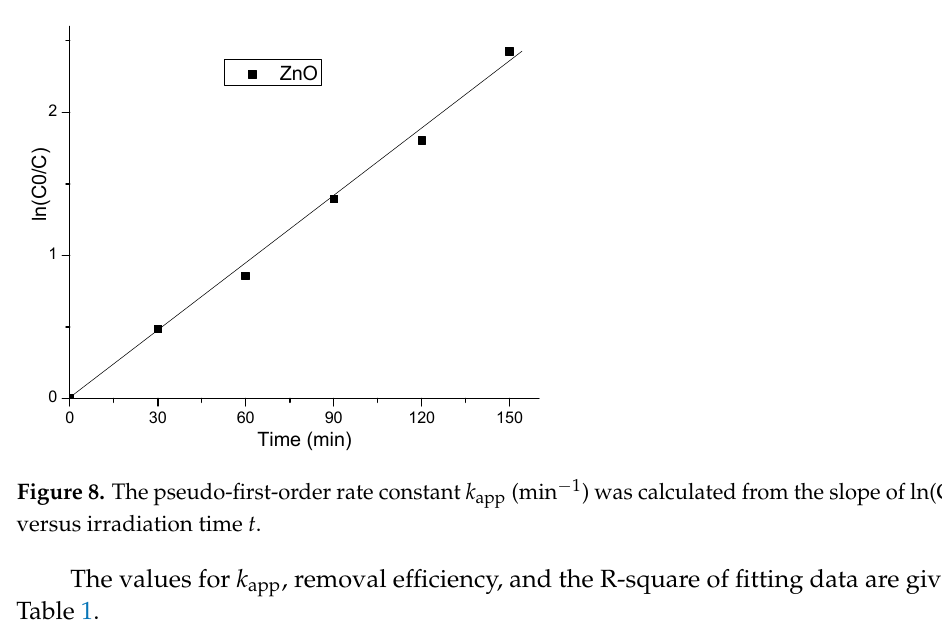
Table 1. The values for k app , removal efficiency, and R-square for ZnO nanoparticles. Sample